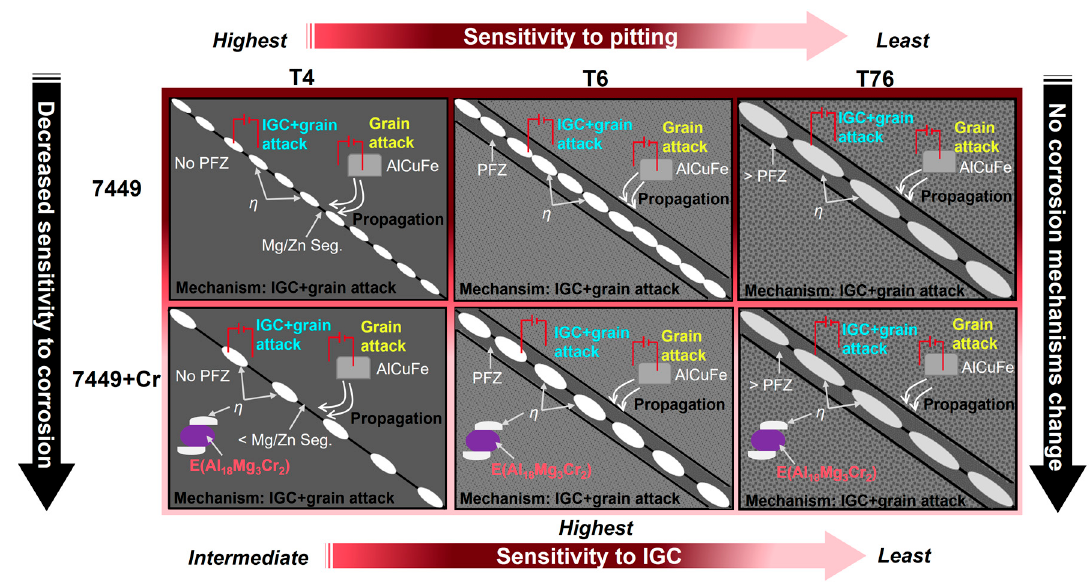
Figure 18. Schematic diagram showing the role of minor Cr addition on microstructure and its correlation to the observed corrosion mechanisms.